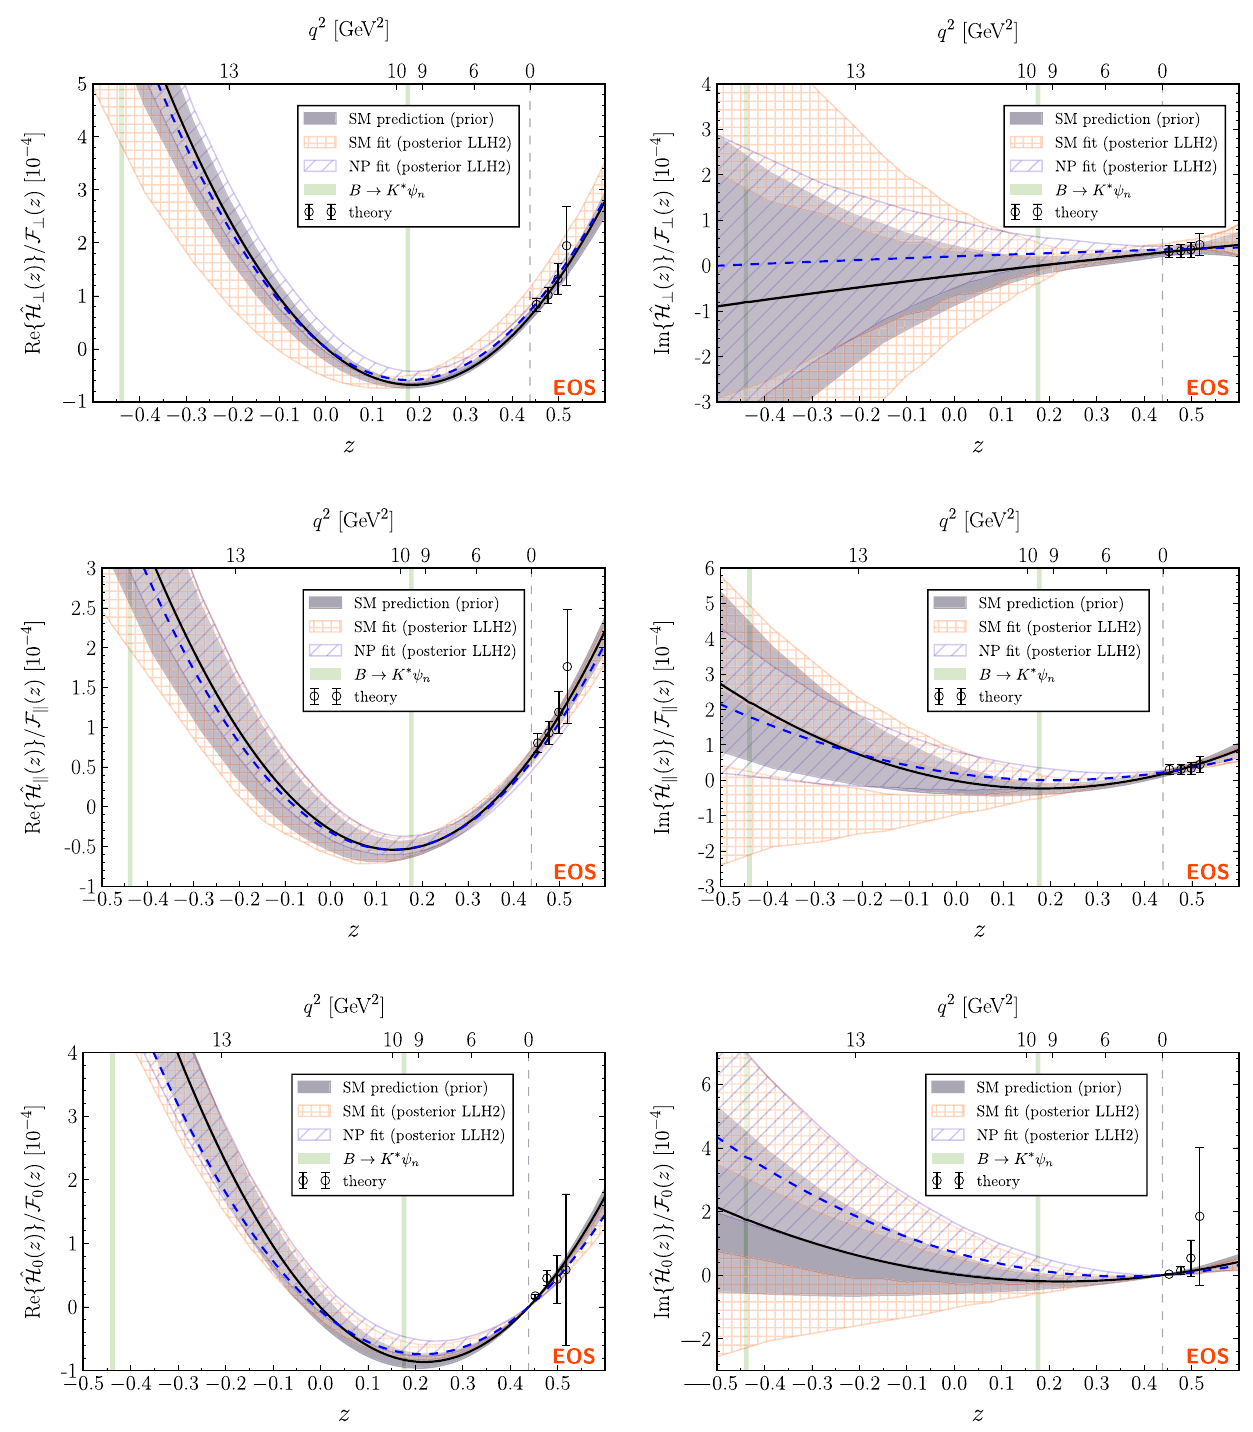
Fig. 5 A-priori predictions of the ratios H λ / F λ as functions of z , and comparison with two a-posteriori results. Note that the SM fit posterior is multi-modal, and we therefore choose not to illustrate its best-fit